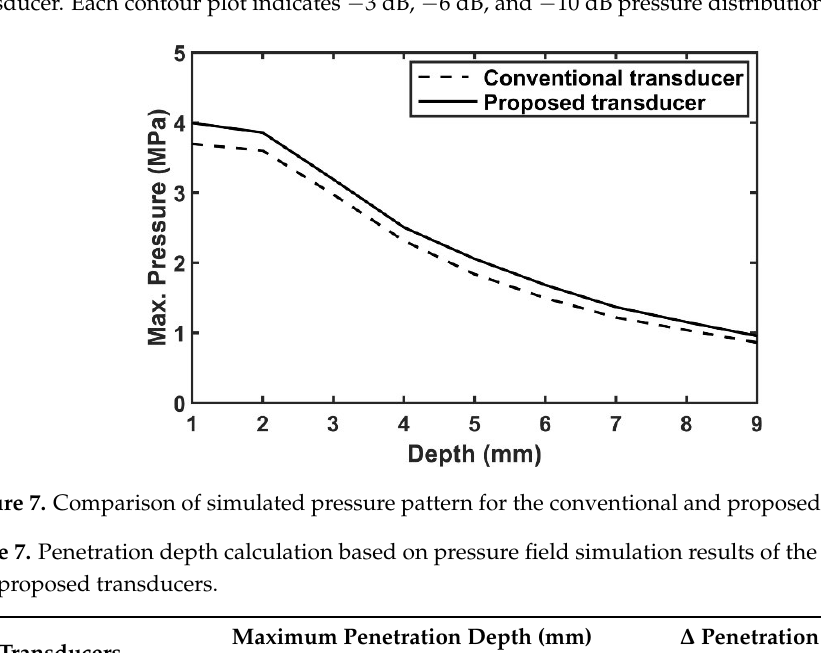
Figure 6. Simulated pressure fields of two transducers: ( a ) Conventional transducer; and ( b ) proposed transducer. Each contour plot indicates −3 dB, −6 dB, and −10 dB pressure distribution. Table 7. Penetration depth calculation based on pressure field simulation results of the conventional and proposed transducers.